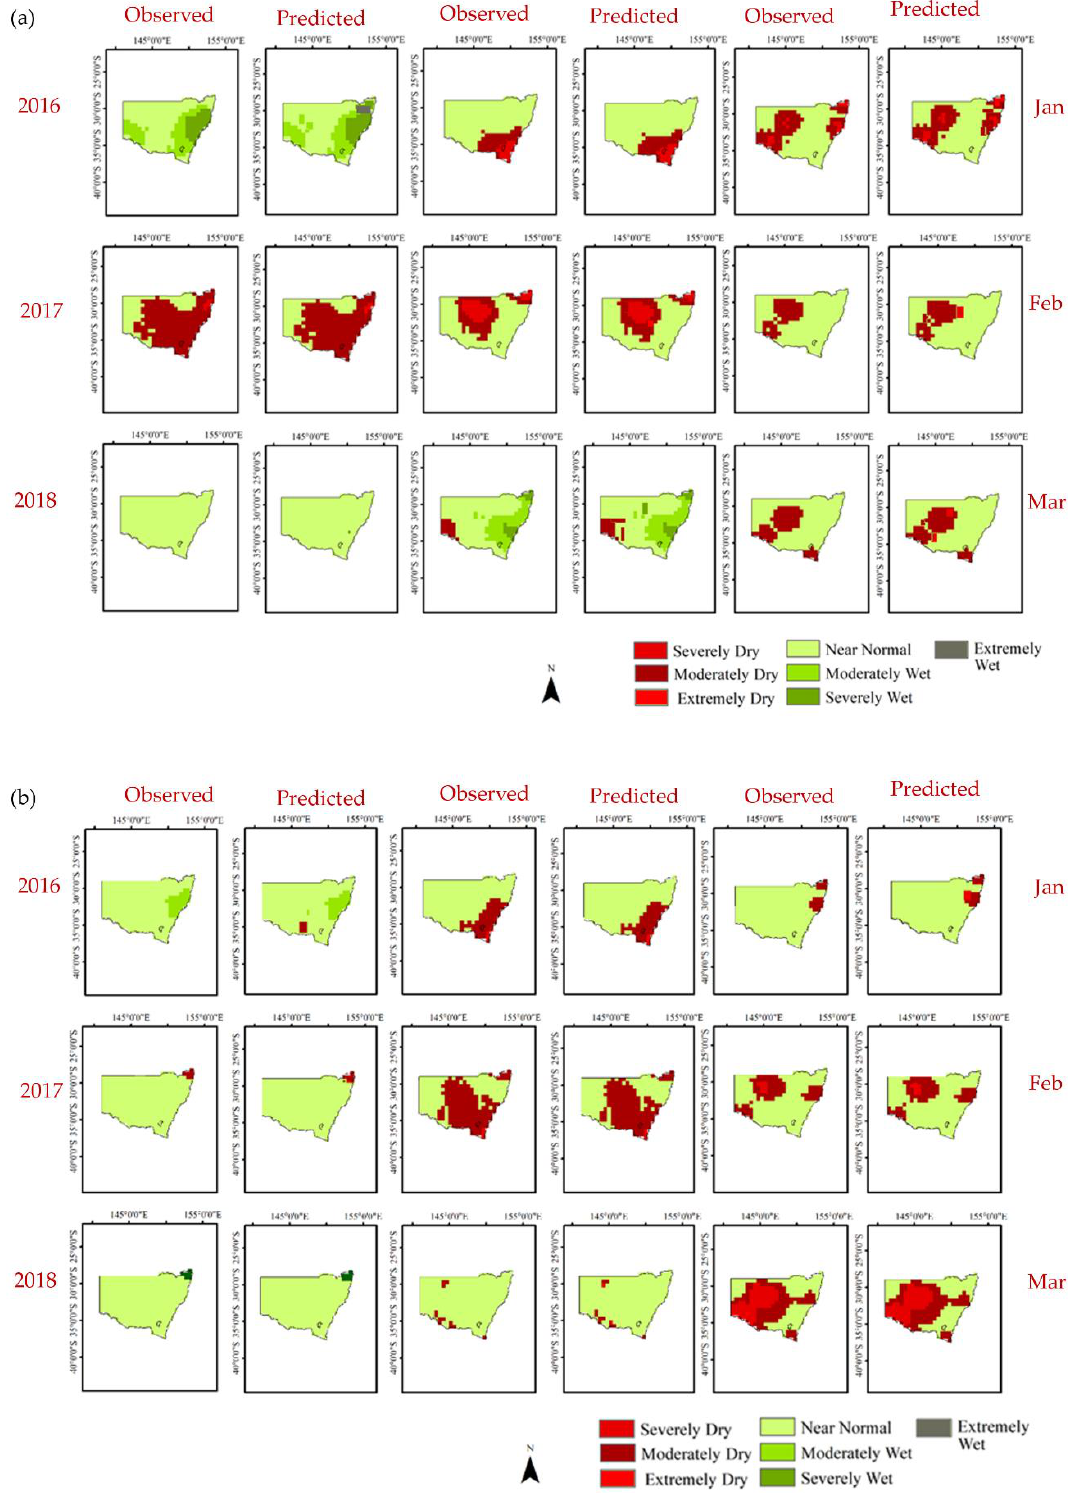
Figure 8. Spatial variation between observed and predicted ( a ) SPEI 1 and ( b ) SPEI 3 values during January–March